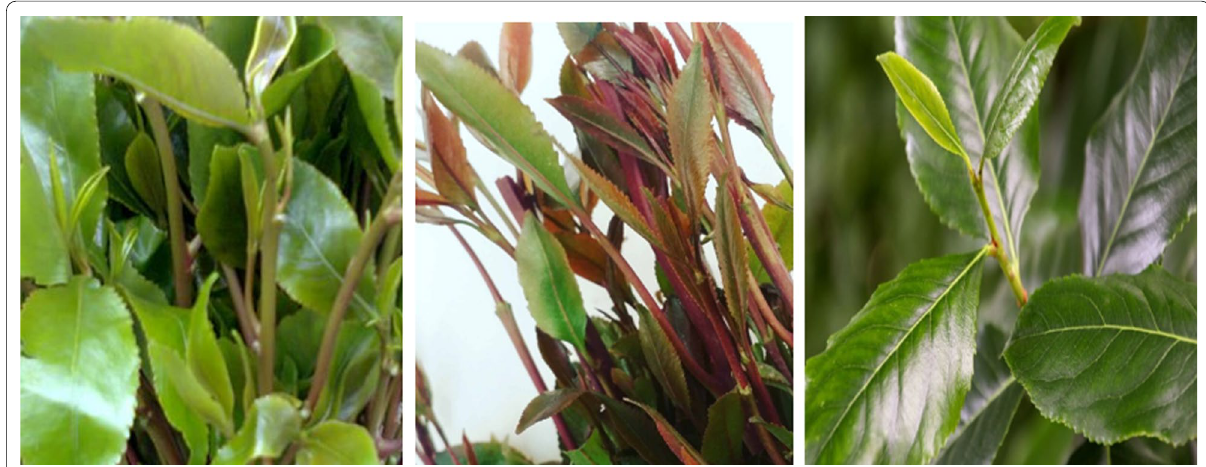
Fig. 1 Samples of fresh khat leaves and shoots— Adapted from Mandi 2019 and Oyugi et al.